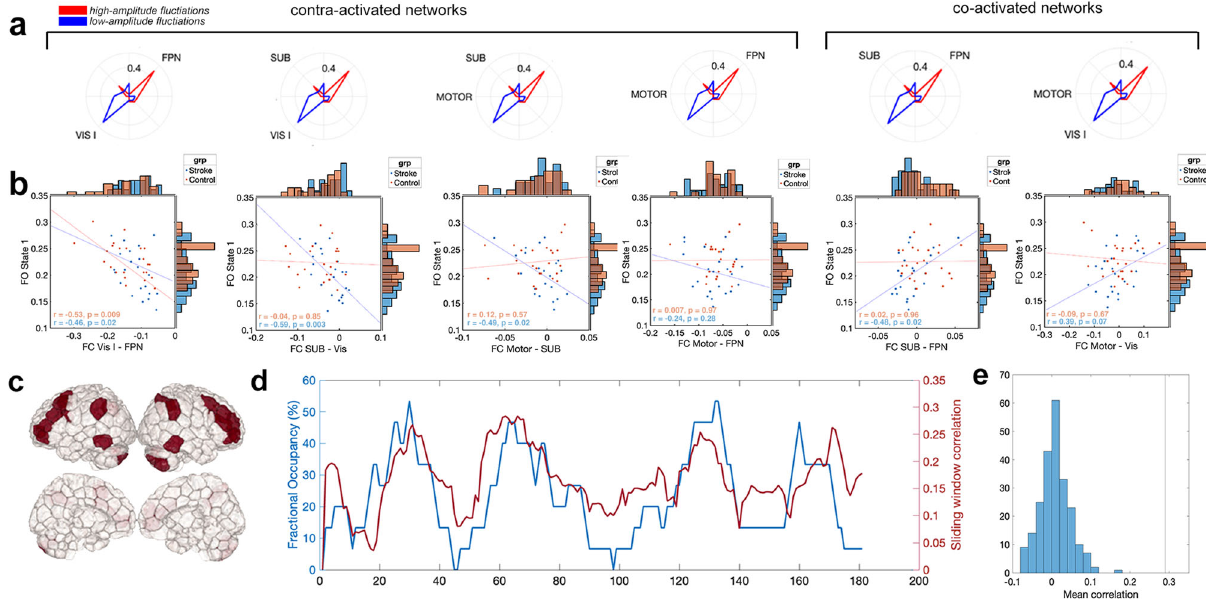
Fig. 6 Assessing the relationship between fractional occupancy of FPN + and functional connectivity within the frontoparietal network. a Pairs of highly activated networks in FPN + . b Functional connectivity (FC) between co-activated and contra-activated networks in FPN + is related to fractional occupancy (FO) of FPN + ( FO FPN þ ) in both stroke and control subjects. Speci fi cally, fewer TRs in a state with strongly contra-activated/co-activated networks results in smaller magnitude FC between those networks. c Areas with high activation in the FPN + centroid. d Dynamic, sliding-window fl uctuations in FO FPN þ correlate with dynamic FC between regions highly active in the FPN (areas in c ). e Subject-average correlation between dynamic, sliding window FO FPN þ and FC of regions highly active in FPN + (black line) and a null distribution of 100 subject-average correlations between dynamic, sliding-window FO FPN þ and FC in a set of randomly selected regions (blue